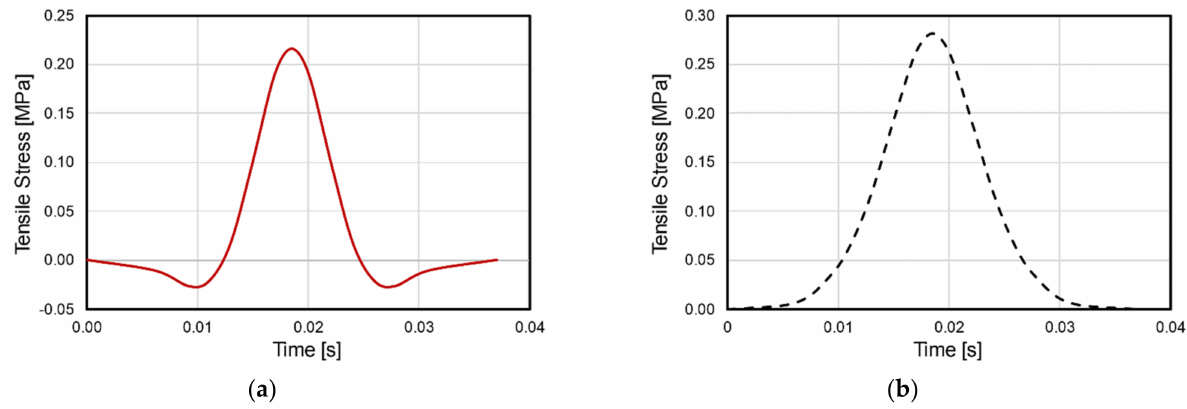
Figure 17. Horizontal stress at the bottom of asphalt slab. ( a ) Longitudinal stress. ( b ) Transverse